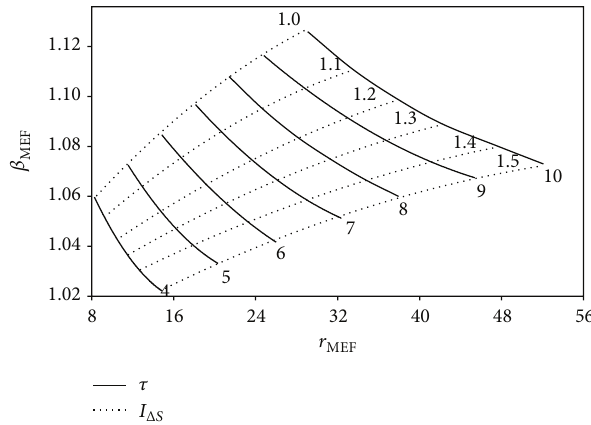
̇𝐸 circumstances based MAX